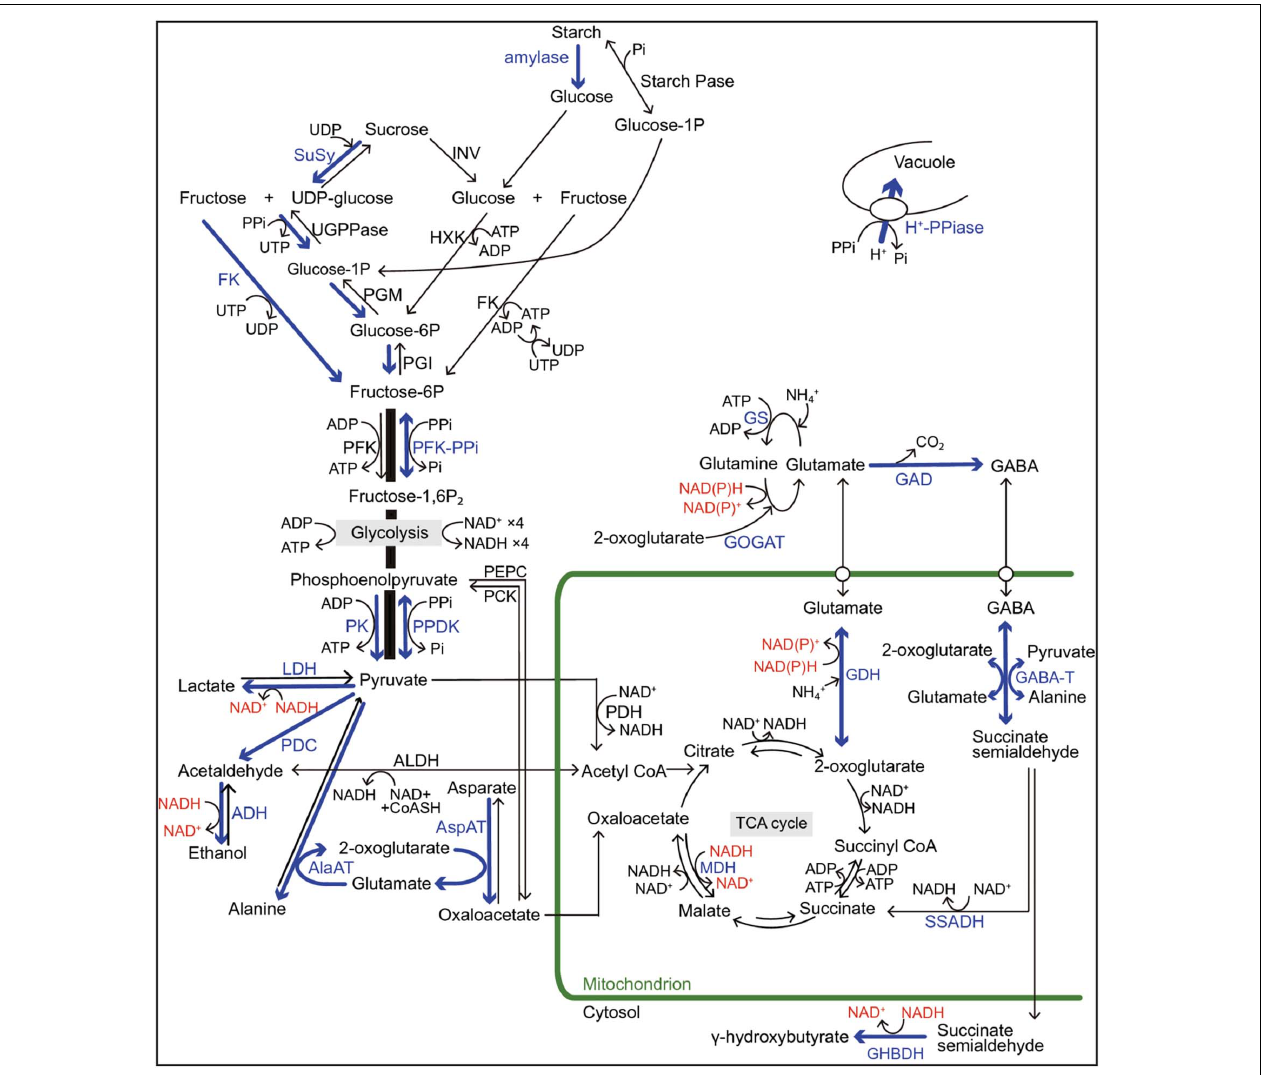
FIGURE 2 | Regulations of sugar catabolism, fermentation, glycolysis, and major amino acid metabolism associated with NAD(P) + regeneration and ATP production in terrestrial and wetland plants under O 2 -deficient conditions. Blue arrows and letters indicate the reactions and enzymes in the up-regulated pathways when the mitochondrial electron transport and the TCA-cycle flux decrease under O 2 -deficient conditions. Red letters indicate the regeneration of NAD(P)+ from NAD(P)H. In rice plants, the blue pathways contribute to their tolerance to long-term O 2 deficiency compared with the terrestrial plants. Some wetland plants such as rice also have a high ability to optimally regulate the pyruvate level by activation of pyrophosphate (PPi)-dependent phosphofructokinase (PFK-PPi) and pyruvate phosphate dikinase (PPDK) that consume PPi instead of ATP for energy conservation. Besides glycolysis, PPi is consumed to regulate the cytosolic pH by the tonoplast H+-pumping pyrophosphatase (H+-PPiase) instead of H+-ATPase in wetland plants. Although two independent pathways for sucrose degradation contribute to the regulation of glycolytic flux in both terrestrial and wetland plants, the UDP-dependent sucrose synthase (SuSy) pathway is regarded as energetically more advantageous for survival under O 2 -deficient conditions than the invertase (INV) pathway because here, PPi is utilized instead of ATP. Sugar supply to glycolysis through starch mobilization is observed in species with developed storage organs such as tuber, rhizome, and endosperm. In NAD(P)H regeneration during the metabolisms of 2-oxoglutarate and glutamate associated with γ -aminobutyric acid (GABA) production, the glutamate dehydrogenase (GDH) pathway without ATP consumption is more efficient in energy consumption than the NAD(P)H-dependent glutamine: 2-oxoglutarate aminotransferase (GOGAT) pathway with ATP consumption. The accumulation of some amino acids such as GABA, alanine, and glutamate play an important role in avoiding carbohydrate loss not only during